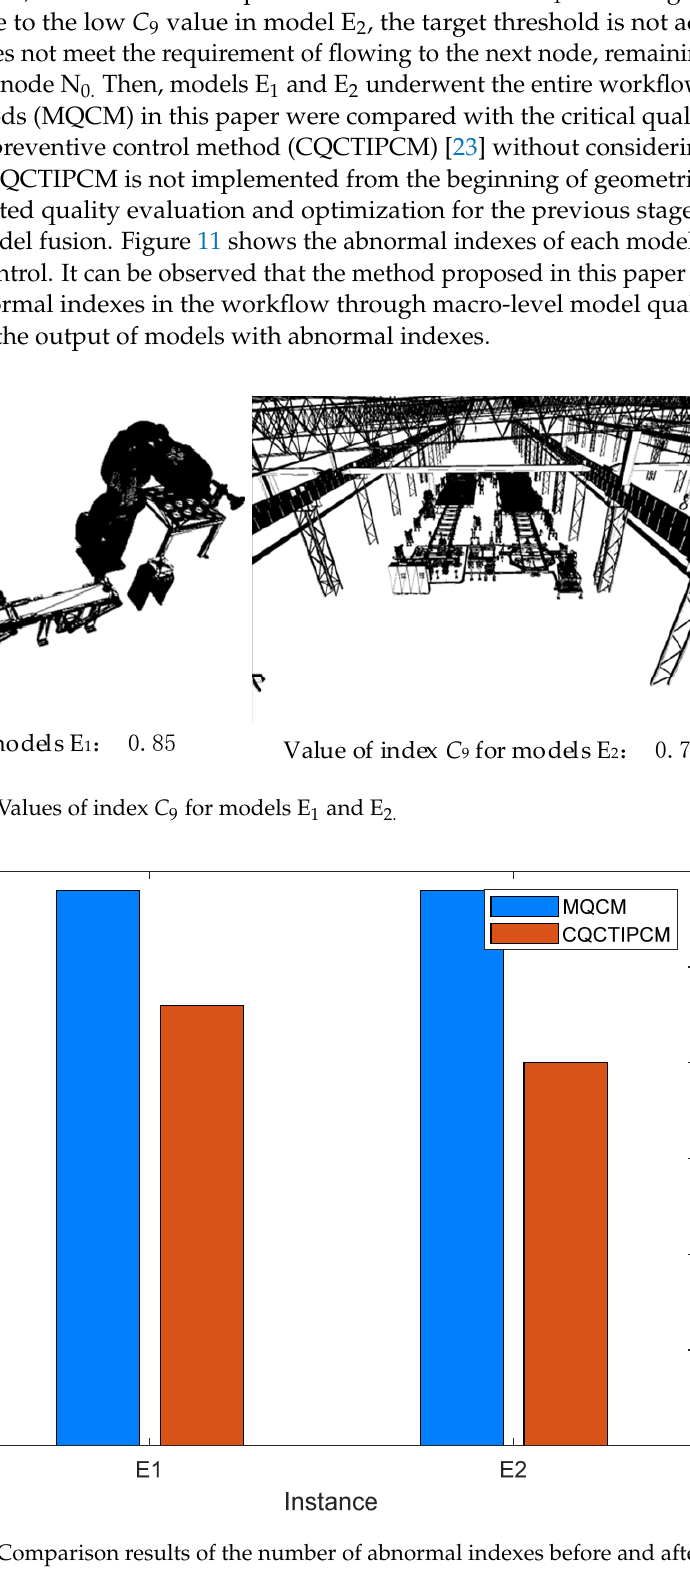
Archive Table 2. Description of transitions in the workflow. Node